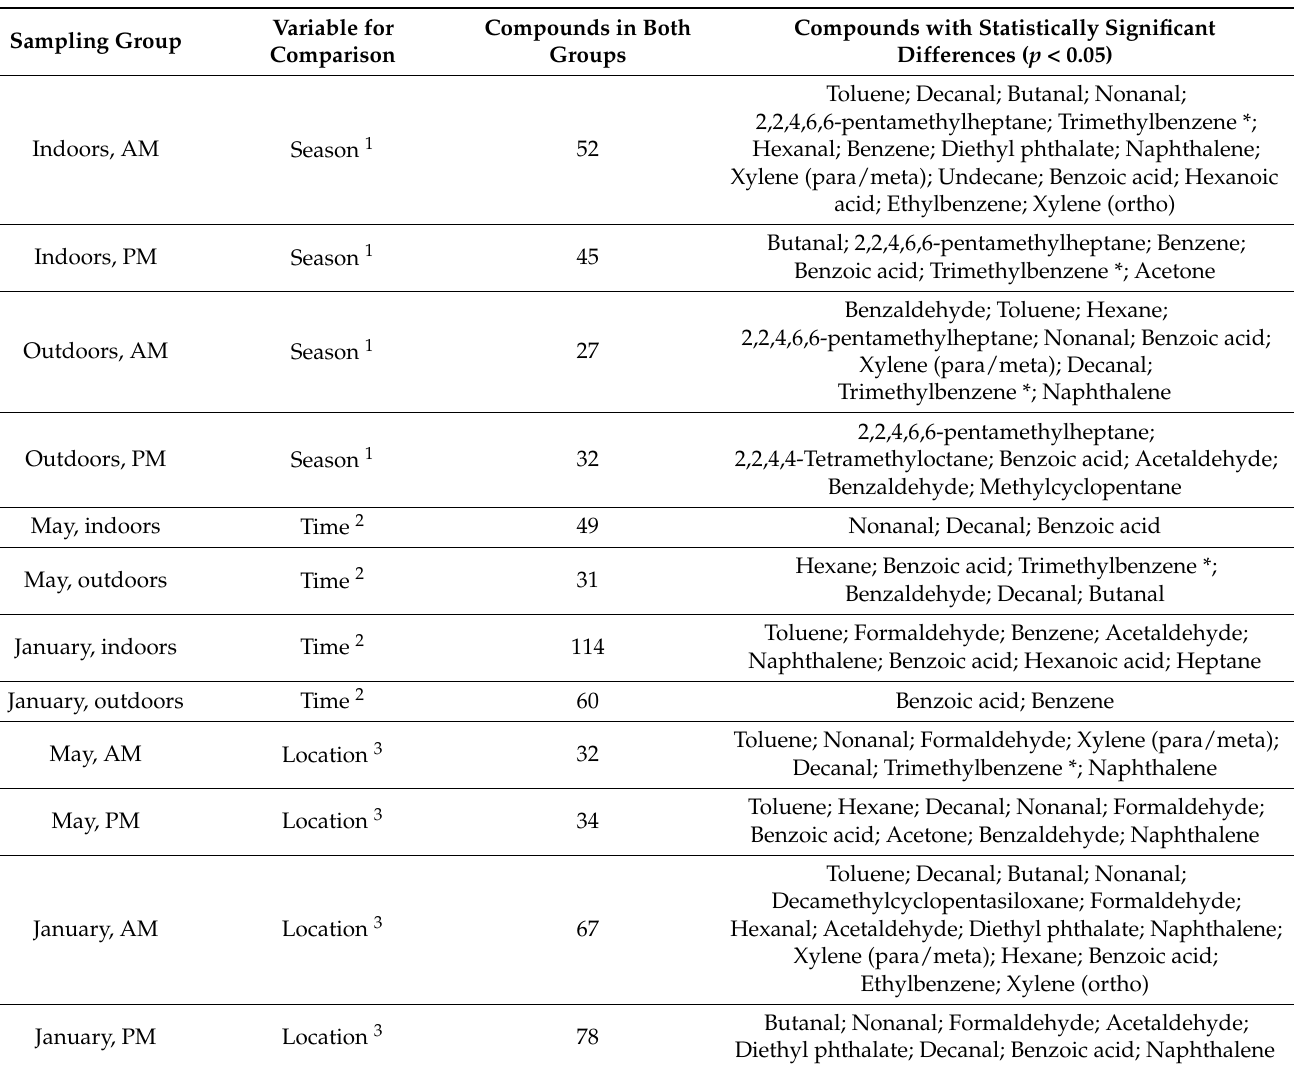
Table 1. Summary of tests of differences (Wilcoxon exact test) between concentrations of compounds in different sampling groups. Compounds in blue were detected in all sampling groups, compounds in black were detected in some but not all sampling